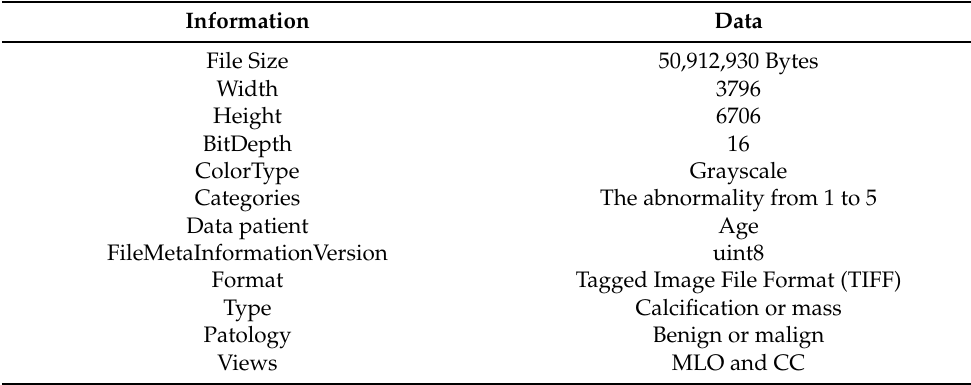
Figure 2. Original mammogram (CC) obtained from CBIS-DDSM data-sets . Table 1. DICOM